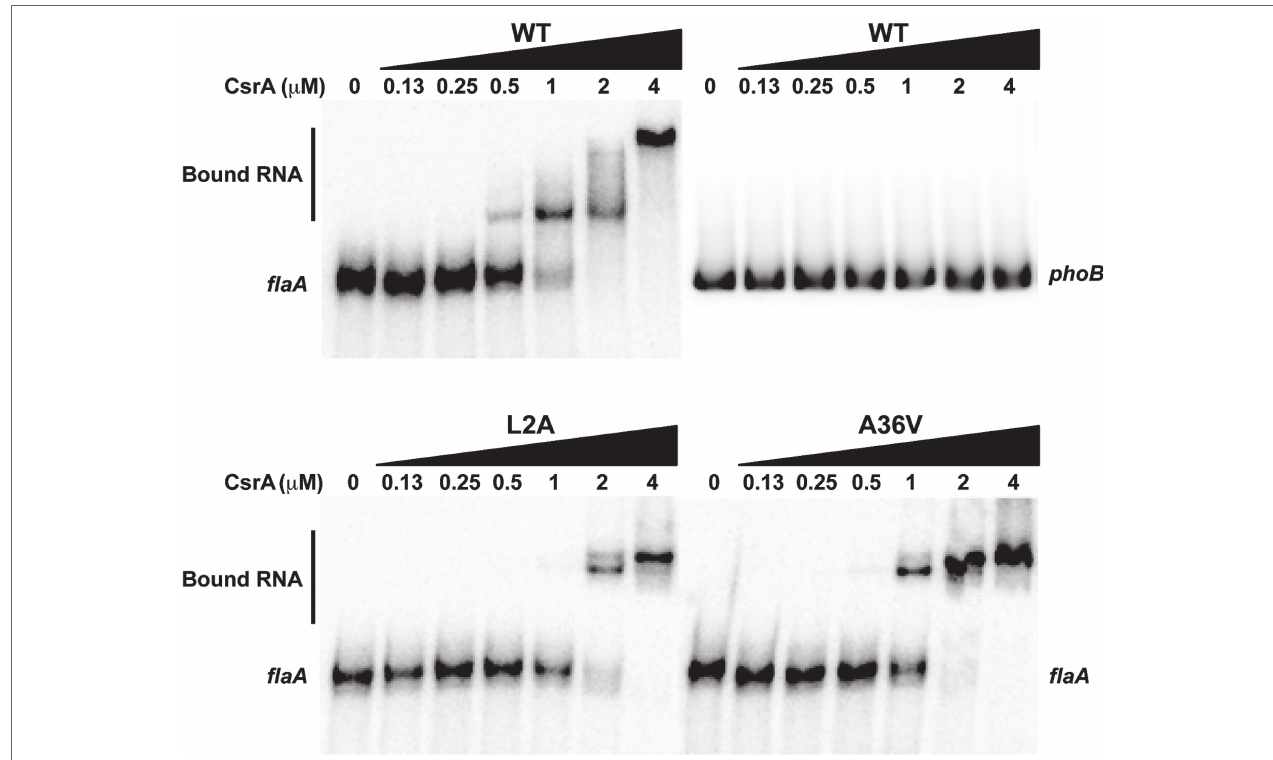
FIGURE 8 | RNA-binding ability of CsrA mutants assessed using EMSA. Purified CsrA-His 6 proteins (WT, L2A, and A36V) were incubated at different protein concentrations (0–4 μM) with 32 P-labeled flaA mRNA (1 nM), resolved on 12% native polyacrylamide gels, and visualized by a phosphorimager. RNA binding by CsrA resulted in decreased migration of the RNA (“Bound RNA”). Labeled E. coli phoB 5 ′ UTR mRNA was used as a CsrA-non-binding